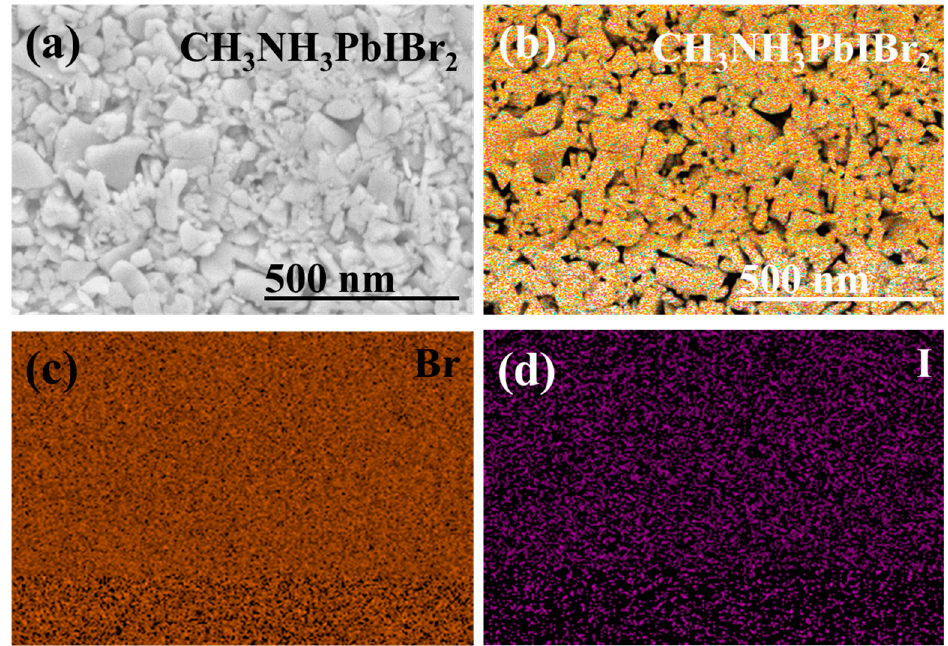
Figure 3. ( a ) Surface SEM analysis of multilayered top layer of CH 3 NH 3 PbIBr 2 thinfilm, ( b ) colored FESEM elemental analysis multilayered CH 3 NH 3 PbIBr 2 thinfilm, Dispersion of Br ( c ) and I ( d ). Ferroelectric ( P-E ) loops of Ag/CH 3 NH 3 PbIBr 2 /Ag, single-layer and multilayer